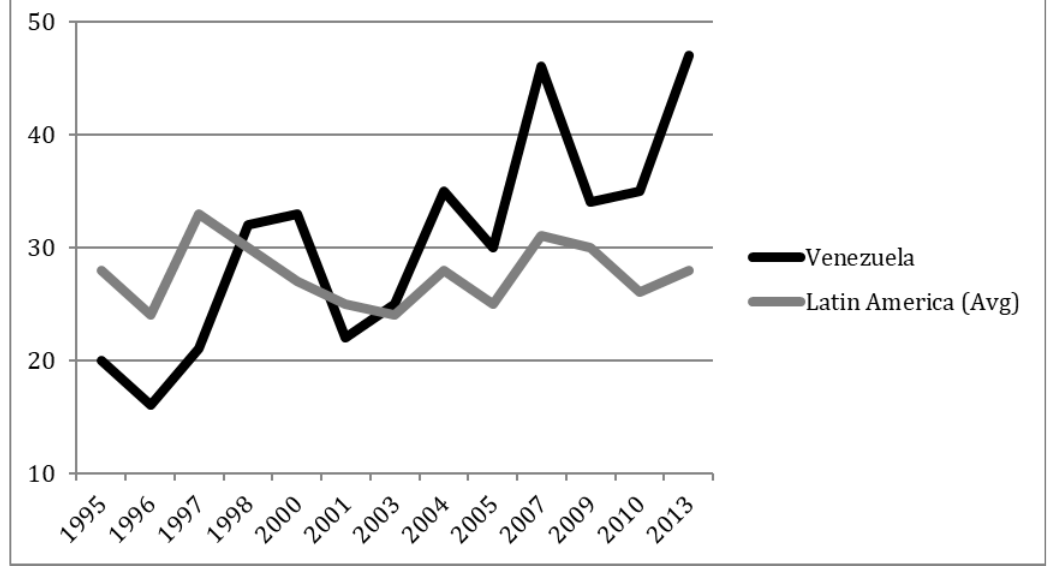
Figure 3 Interest in Politics,